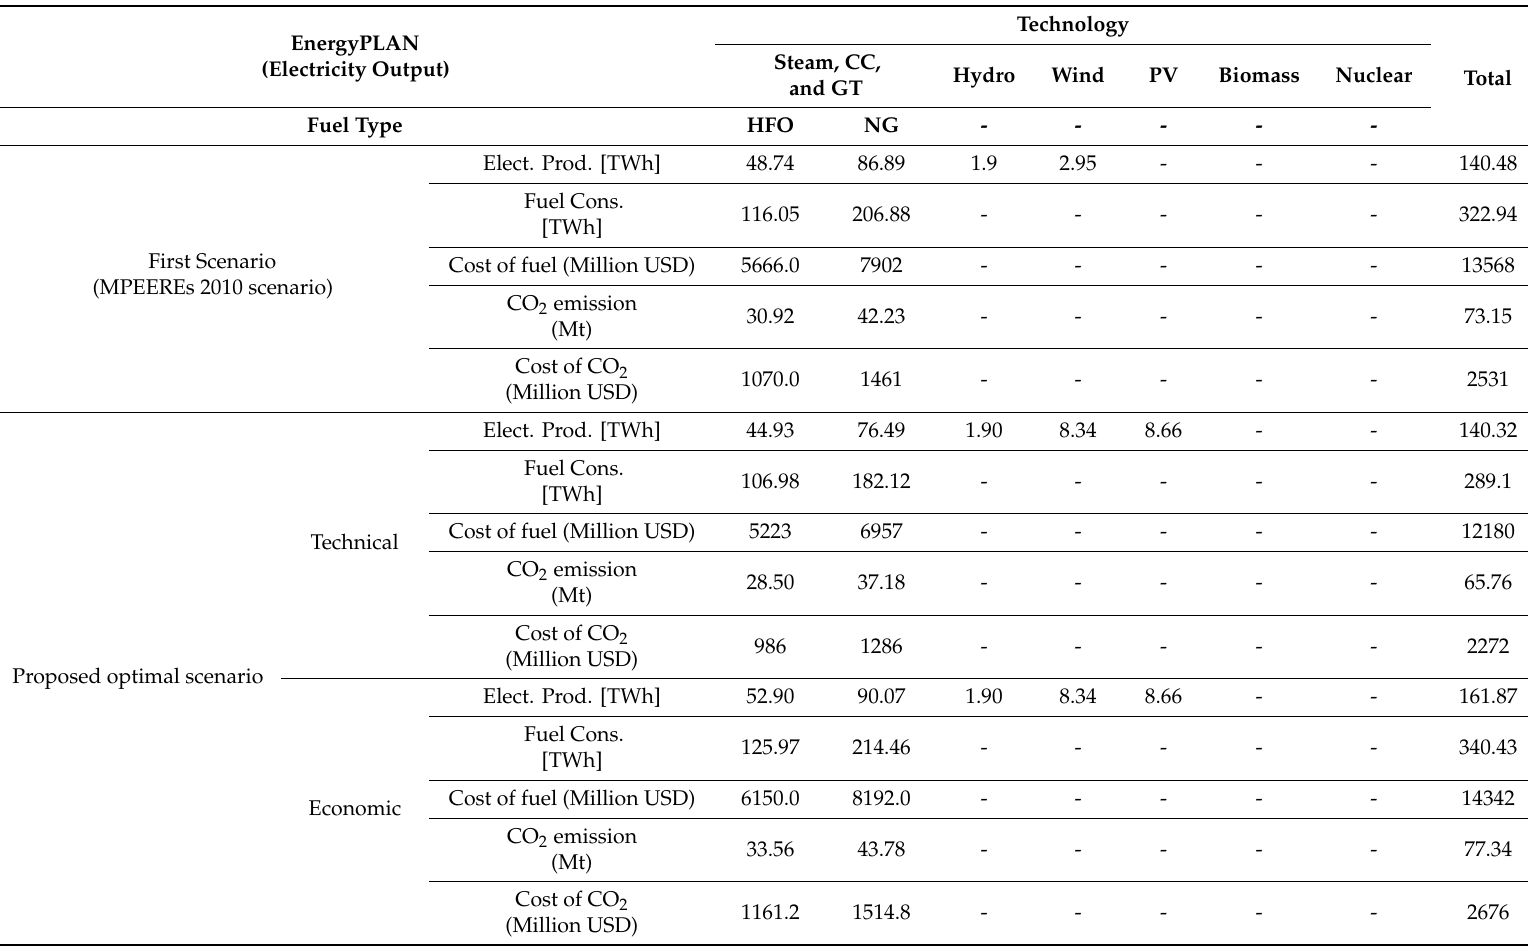
Table 12. Electricity production, fuel consumption, cost of fuel, CO 2 emission, and cost of CO 2 for the MPEERE 2010 and proposed